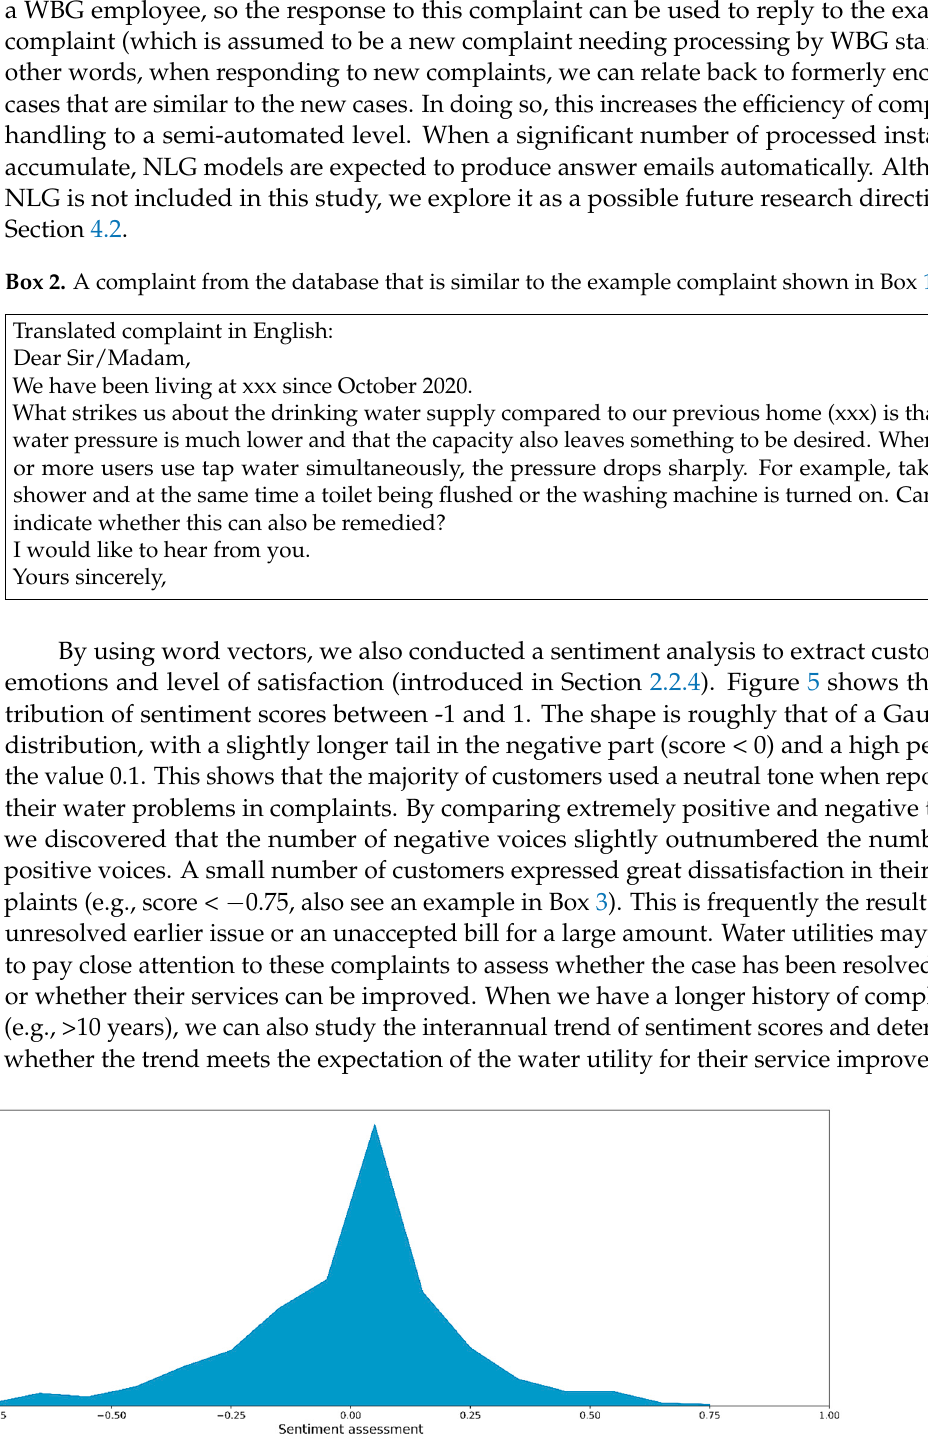
Figure 5. Sentiment score distribution of collected complaints. Box 3 . An example of a complaint with a sentiment score of − 1.